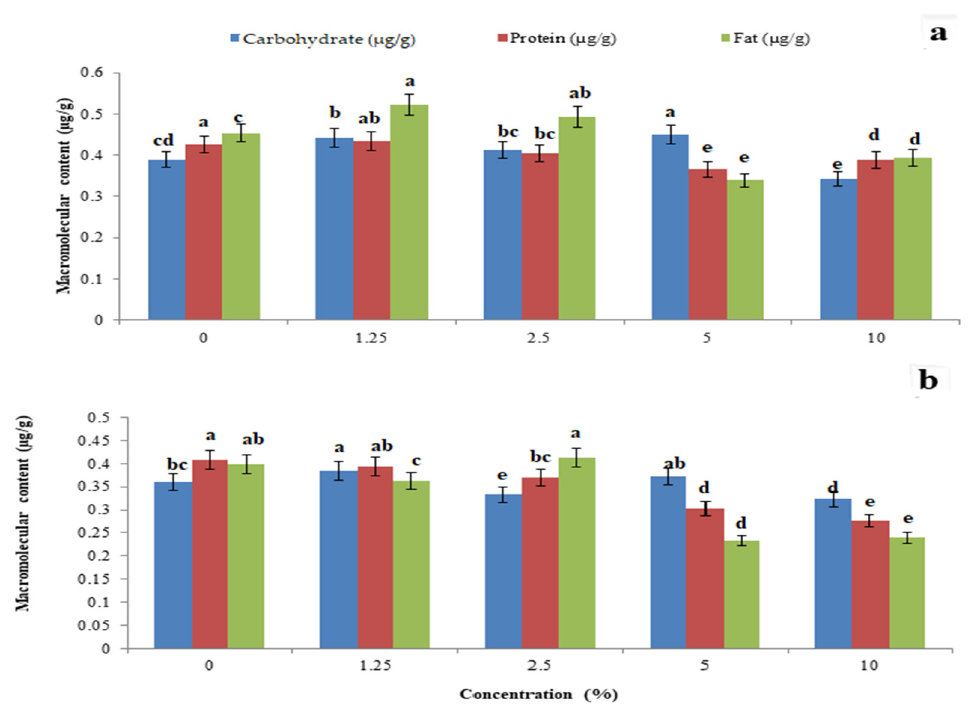
Figure 8. Whole-body carbohydrate, protein, and fat ( µ g/g) of P. solenopsis exposed to different concentrations of J. adathoda ( a ) and J. adathoda- AgNPs ( b ). Different letters (among the same concentration for each enzyme separately) above bars indicate significantly different means according to Tukey’s test ( p < 0.05). Bars indicate the standard error (SE)